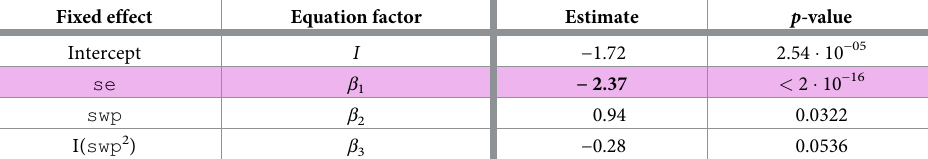
Table 2. Predictors values for the fitted mixed model. We can observe the very significant impact of the se predictor on the observed outcome.